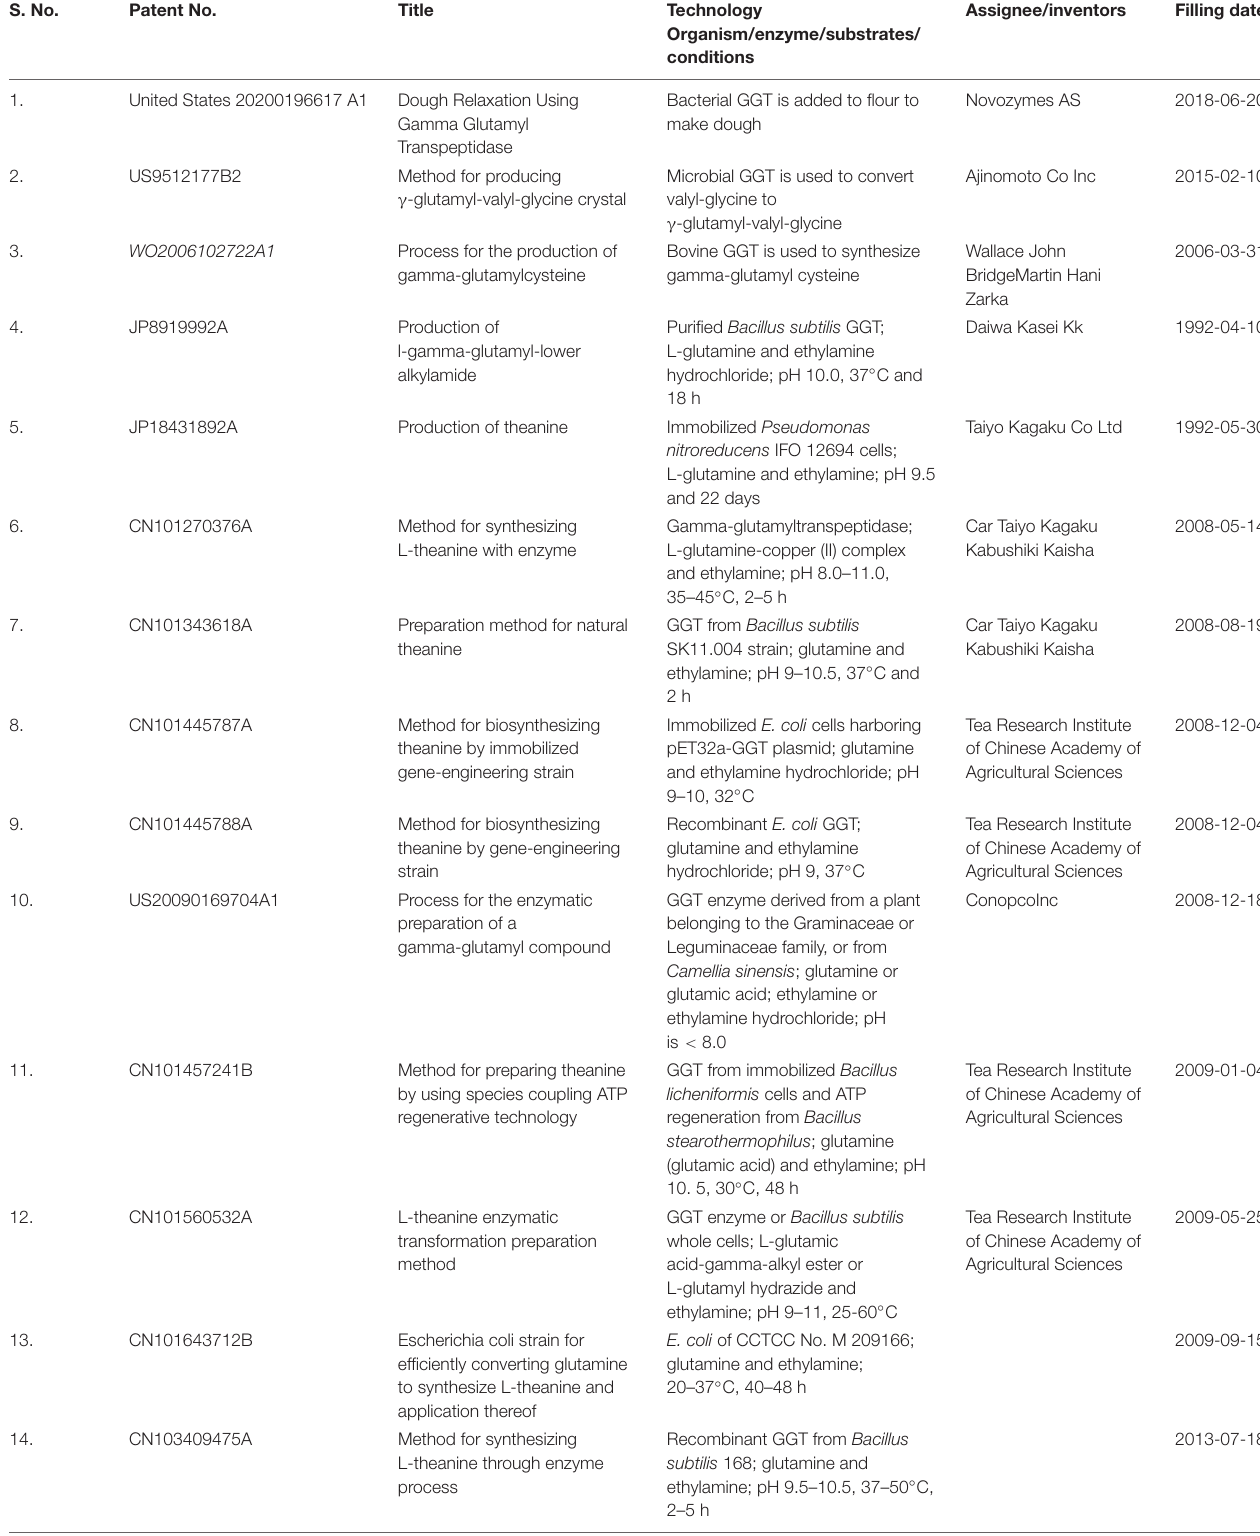
TABLE 8 | List of patents on applications of bacterial gamma-glutamyl transpeptidases (GGTs). S. No. Patent